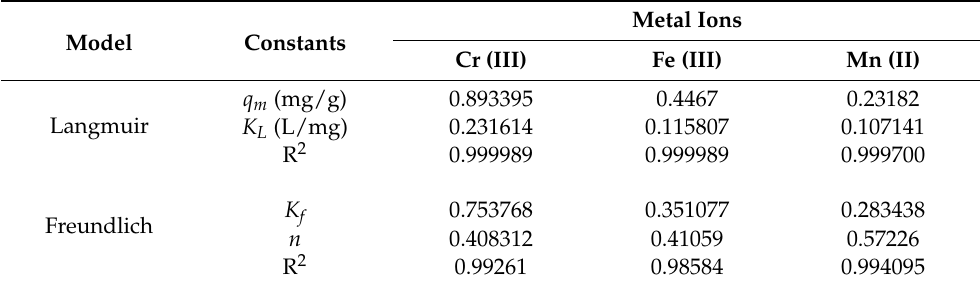
Table 4. Adsorption isotherms constants for adsorption of Cr (III), Fe (III), and Mn (II) on (Ch/g-